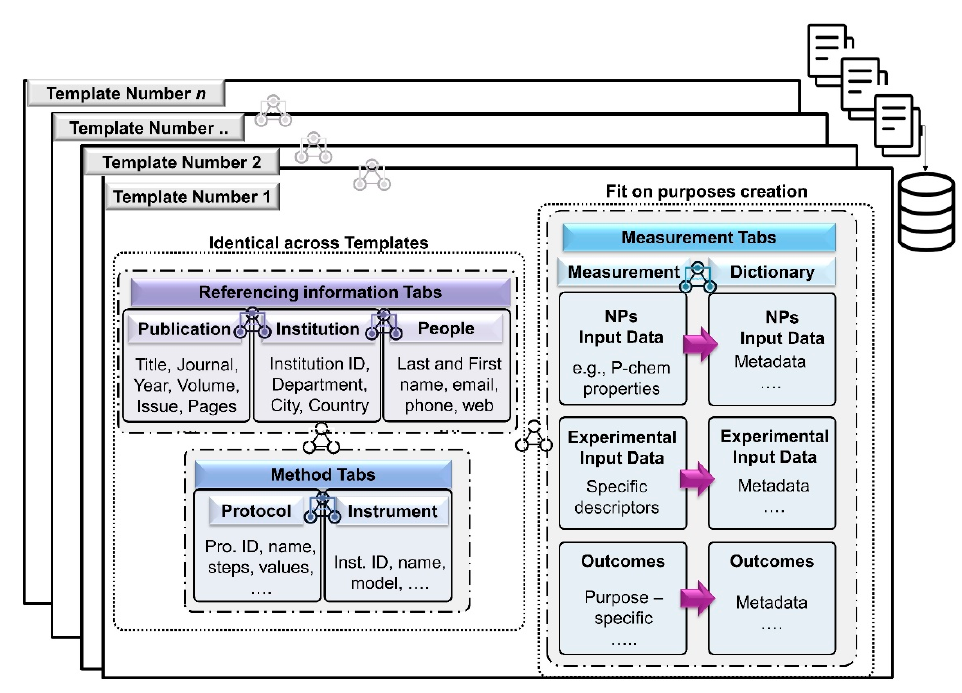
Figure 3. Dataset visualization. Tabs and variables included in each tab.